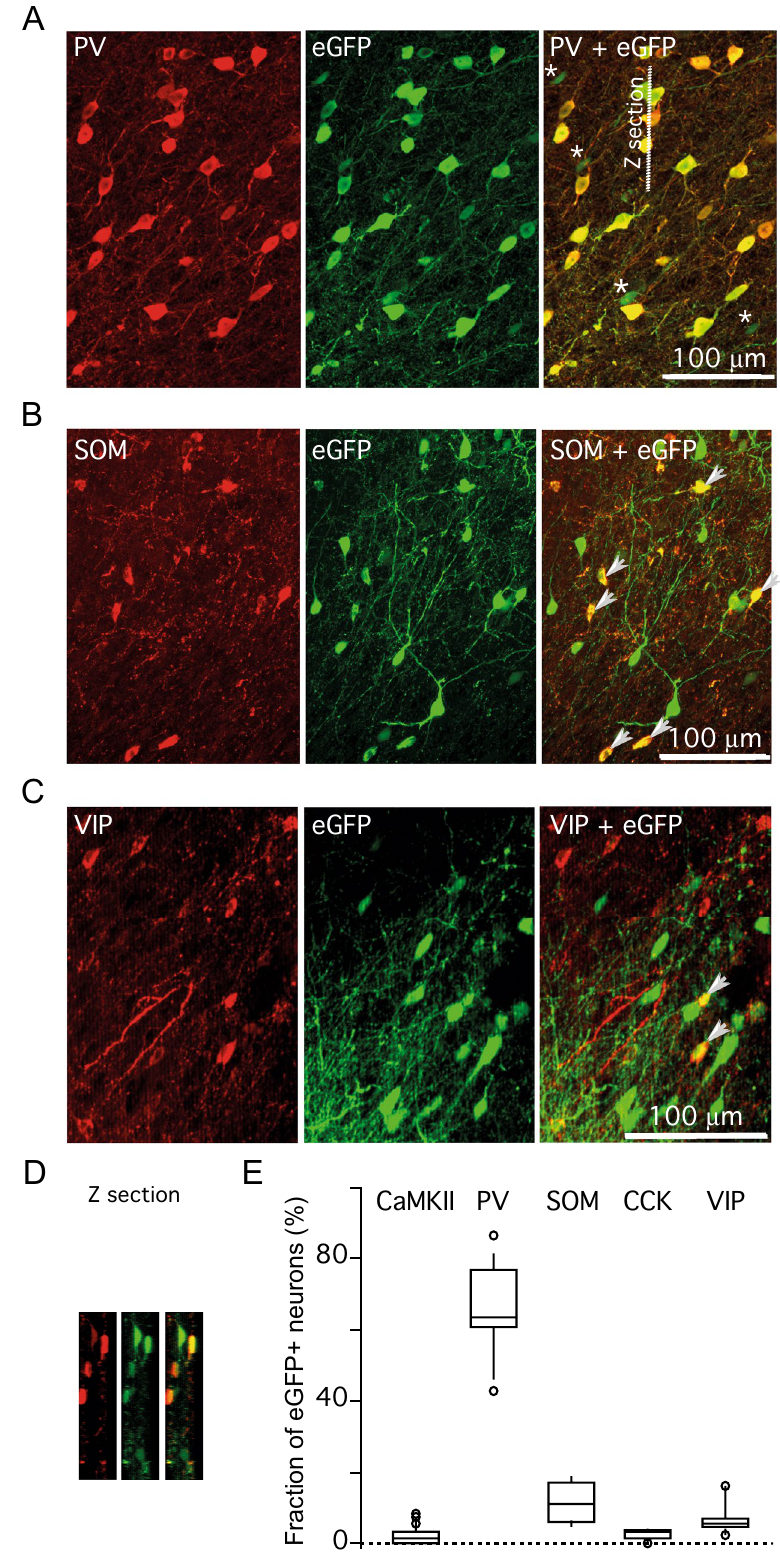
Figure 3. PV promoter driven eGFP is mainly expressed in PV positive neurons. ( A ) Fluorescence images of a brain section stained for PV antibody (left), the virus reporter eGFP fluorescence (middle) and merged two images (right). Most the rAAV eGFP containing neuronal somata were also positive for PV as indicated by the yellow merged colour. The few rAAV eGFP cells negative for PV are indicated by asterisks. ( B , C ) Fluorescence images of a brain section stained for SOM (in B) or VIP (in C ) antibody (left), the virus reporter eGFP fluorescence (middle) and merged two images (right). Arrows indicate neuronal somata that contain both the rAAV eGFP and SOM or VIP antibody fluorescence. ( D ) A sample of a Z section along the dashed line shown in ( A ). ( E ) A box and whisker plot summarizing co-expression data. The whiskers indicate 10–90%